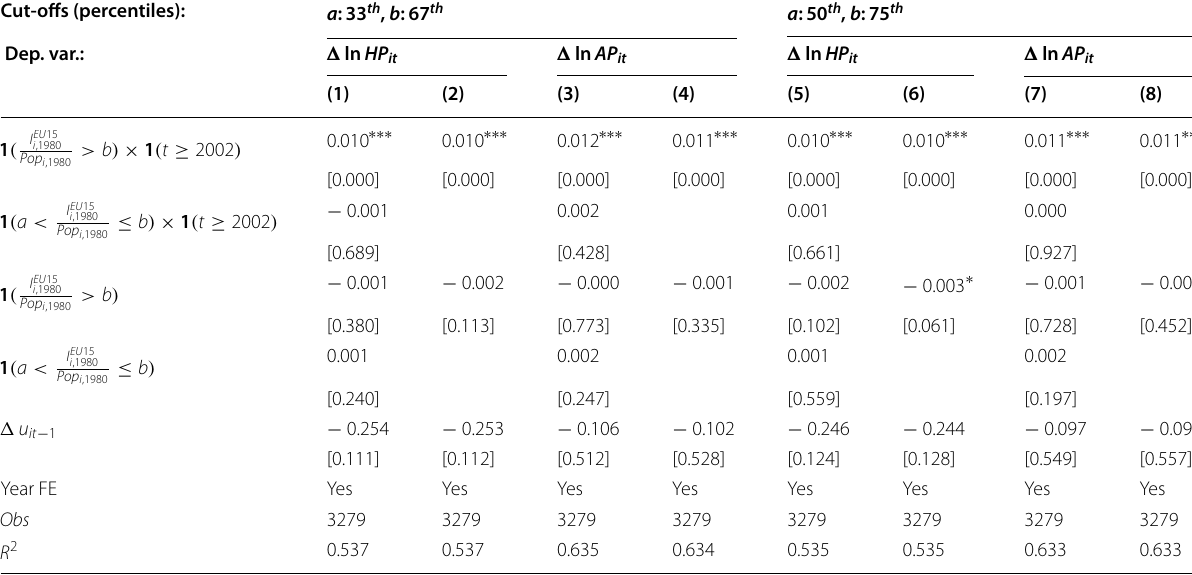
Table 8 House prices and immigration—MS-regions from 1985–2016: Event study. Source: Own calculations based on data from Wüest Partner and Federal Statistical